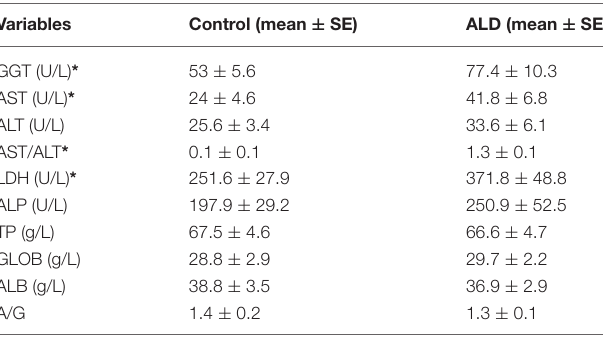
Serum plasma chemistry parameter with an asterisk indicates a significant difference (p < 0.05) between control rhesus monkeys and rhesus monkeys with alcohol induced liver